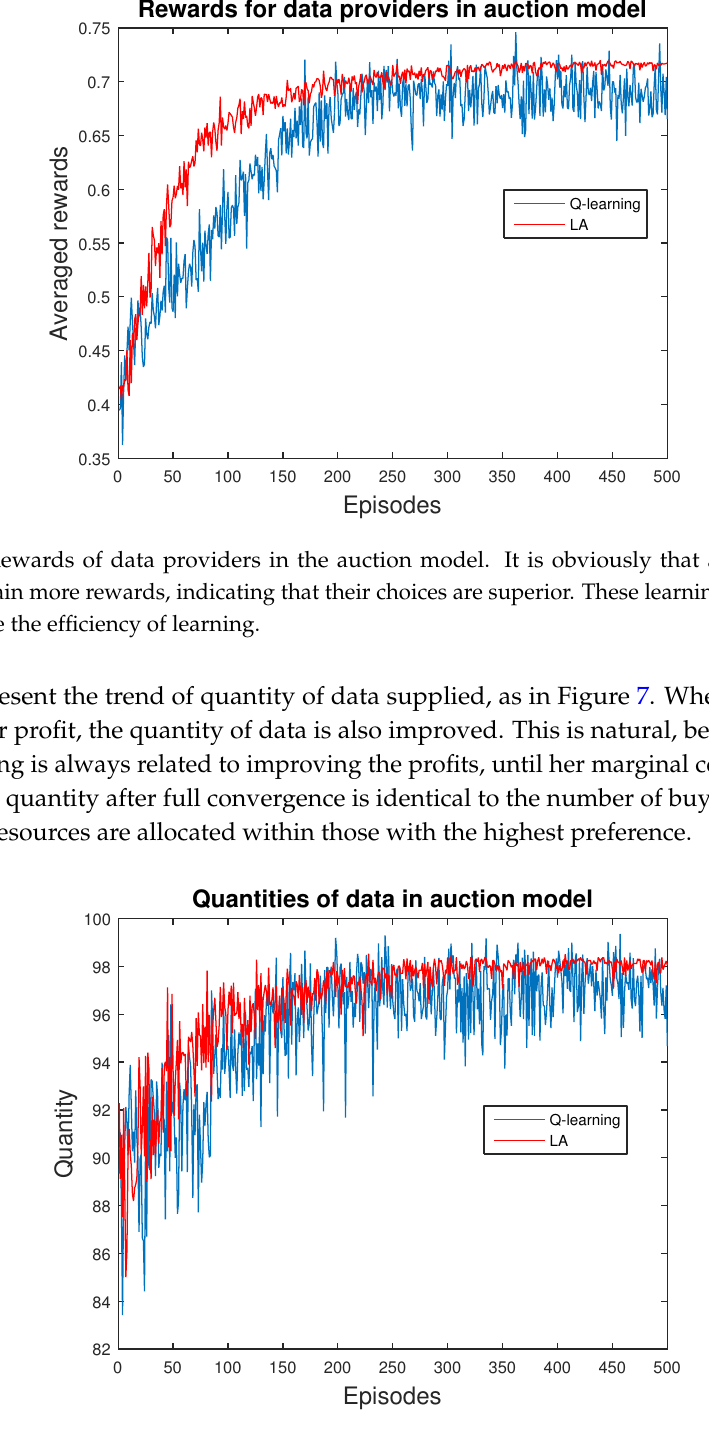
Figure 7. Quantity of data in this market. Notice that the curves are similar to those in Figure 6, due to the method of assigning rewards for each